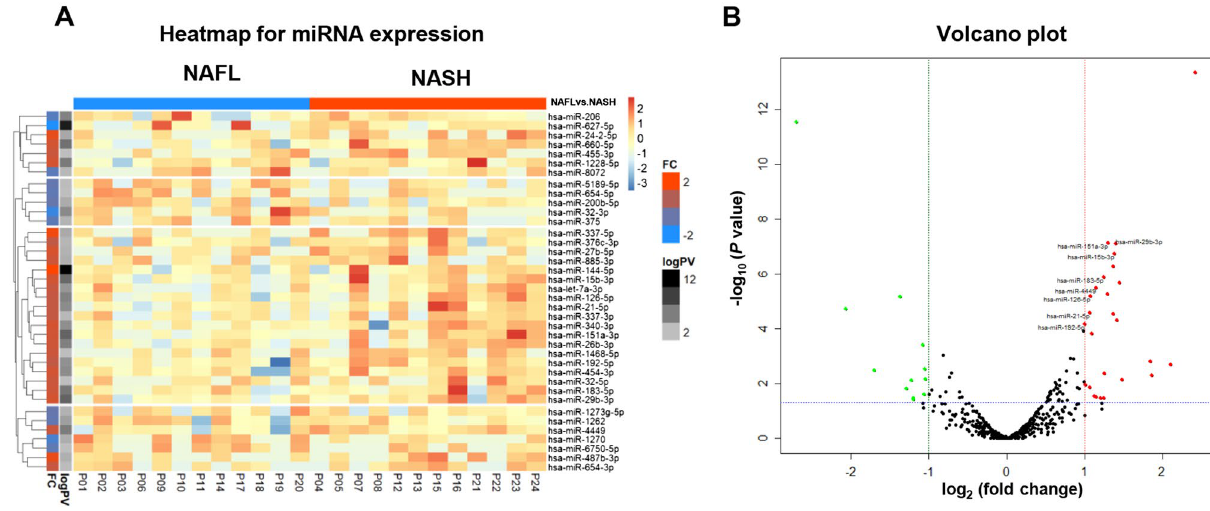
Figure 1. Heatmap ( A ) and volcano plot ( B ) of miRNA expression profile in sera of patients with NAFL and NASH. In heatmap, column annotation bar indicates two groups of disease (NAFL and NASH), and two row annotation bars indicate P -value and fold change between two groups. In row annotation bars, black and red color indicate high significance and higher expressed in NASH. Green dots indicate miRNA with decreased expression [log 2 (fold change) − 1] in NASH group ( P < 0.05). Red dots indicate miRNA with increased expression [log 2 (fold change) > 1] in NASH group ( P < 0.05). The dashed blue line represents where P < 0.05 and the threshold for high statistical